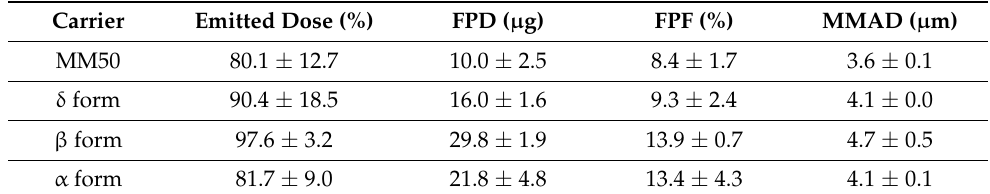
Table 3. Deposition profiles of salbutamol sulphate from lactose MM50, or mannitol α , β and δ in an ACI after aerosolization with RS01 ® at 60 L min − 1 (mean (SD), n = 3).